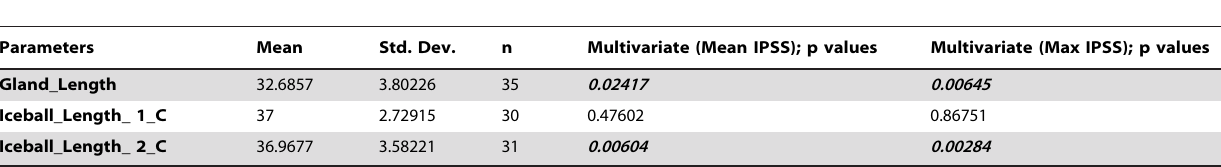
Table 4. Simplified analysis of gland length and the largest iceball dimension against IPSS scores.